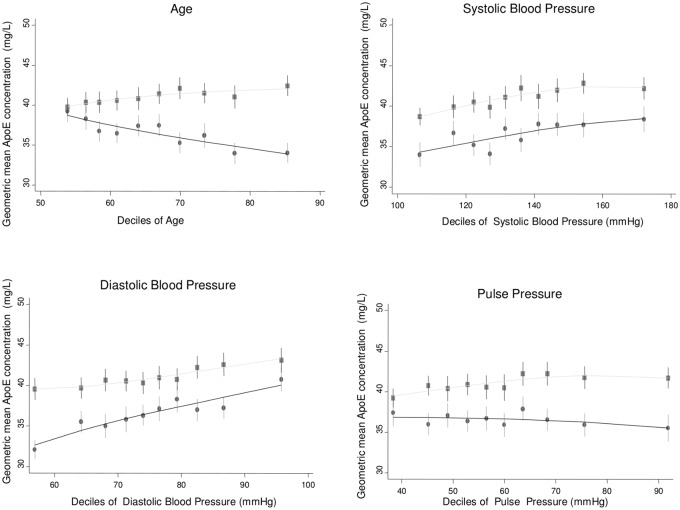
Cross-sectional association between geometric mean of ApoE concentration and age, systolic blood pressure, diastolic blood pressure, and pulse pressure measured in ELSA, by gender.Male (circles) and female (square) mean log ApoE concentration was calculated for each decile of the associated variable and plotted to visualise the shape of the association. Bars give 95% CIs.